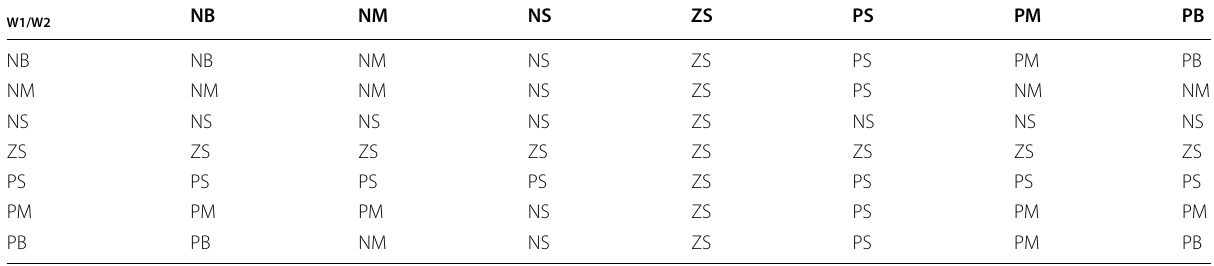
Table 23 Mapping between inputs and output of ANFIS